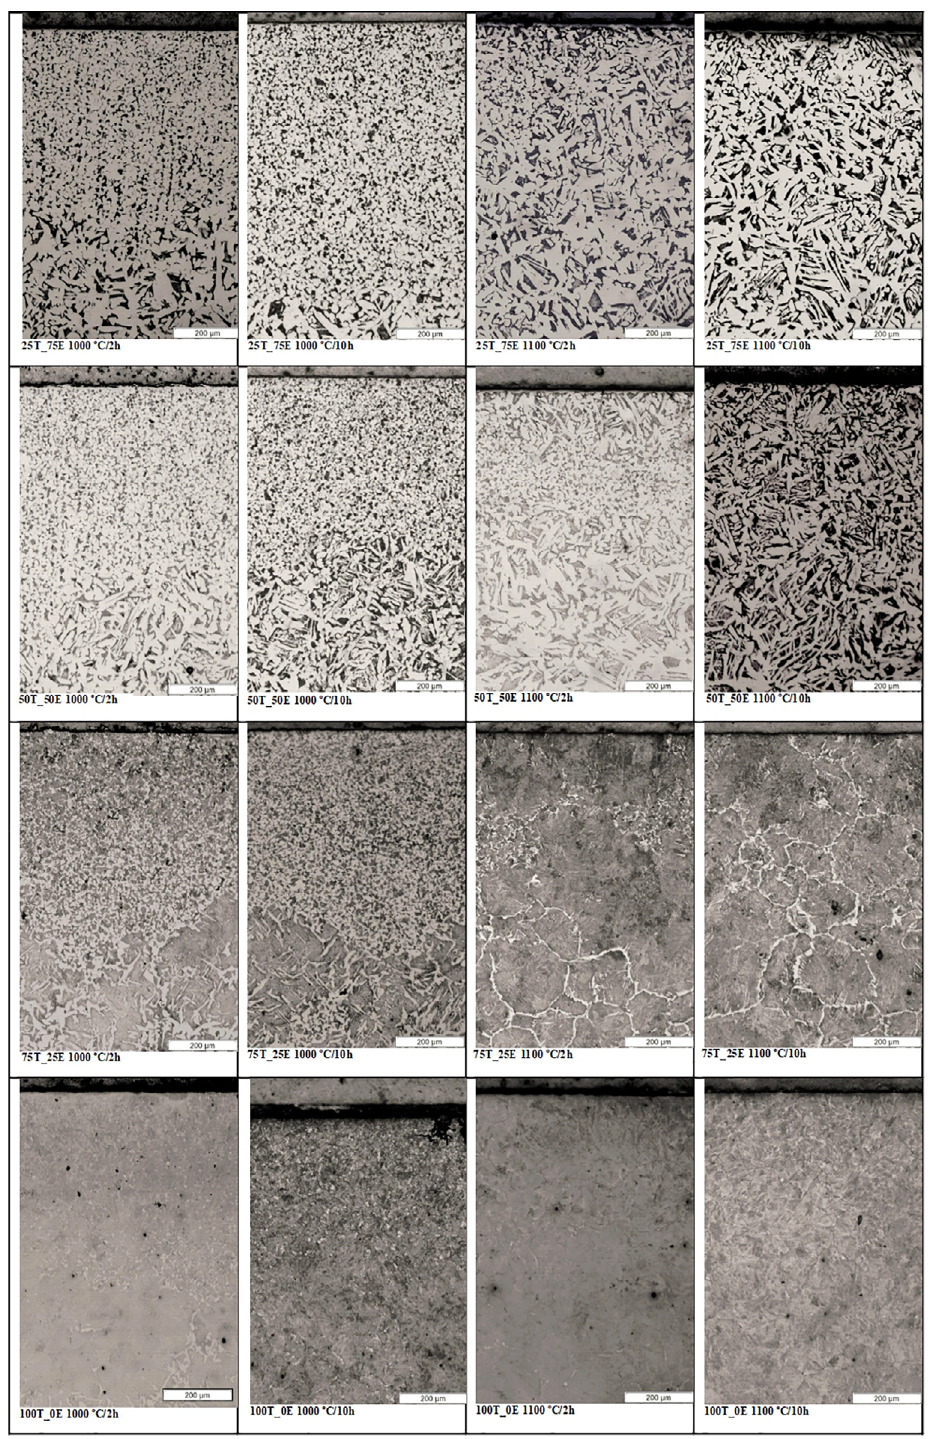
Figure 5. Cross-sections optical micrographs (mag. 100x) of AISI 1020 steel thermochemically treated with Turbonit ® and mixtures Tubonit ® +Ekabor ® (2 h and 10 h at 1000º C and 1100º